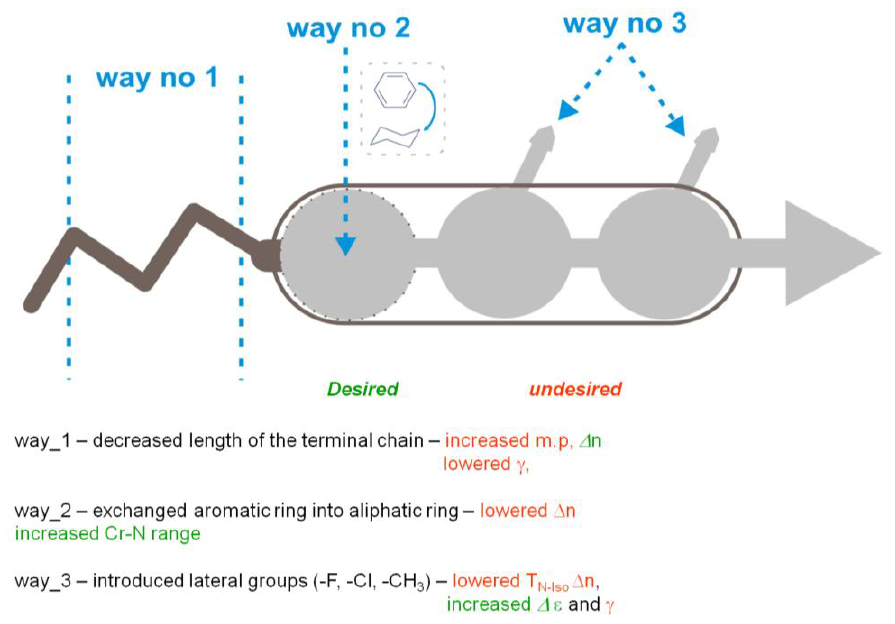
Figure 16. Influence of different molecular units on the birefringence